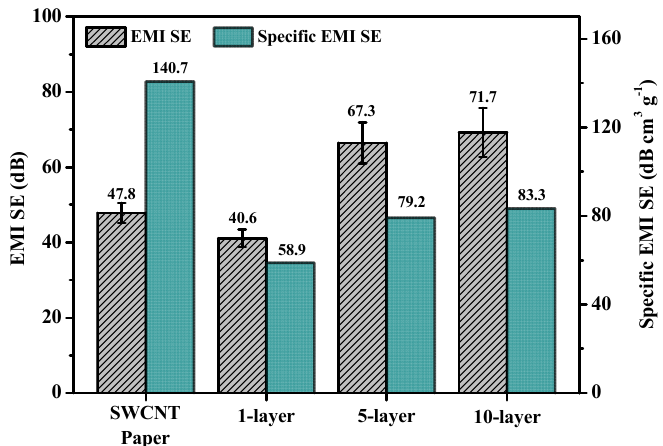
Figure 6. EMI SE and specific EMI SE results of SWCNT paper and 1-, 5-, and 10-layer composites.